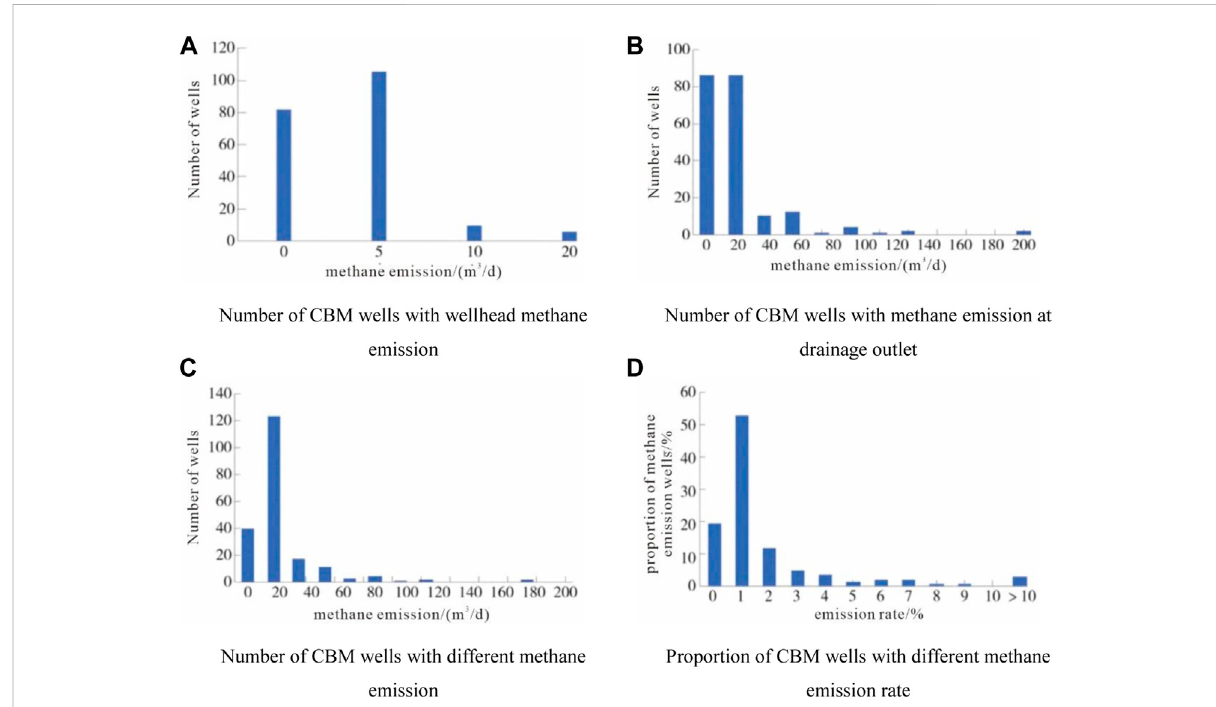
FIGURE 5 Statistics of CBM wells with different methane emission and emission rates (A) Number of CBM wells with wellhead methane emission (B) Number of CBM wells with methane emission at drainage outlet (C) Number of CBM wells with different methane emission (D) Proportion of CBM wells with different methane emission